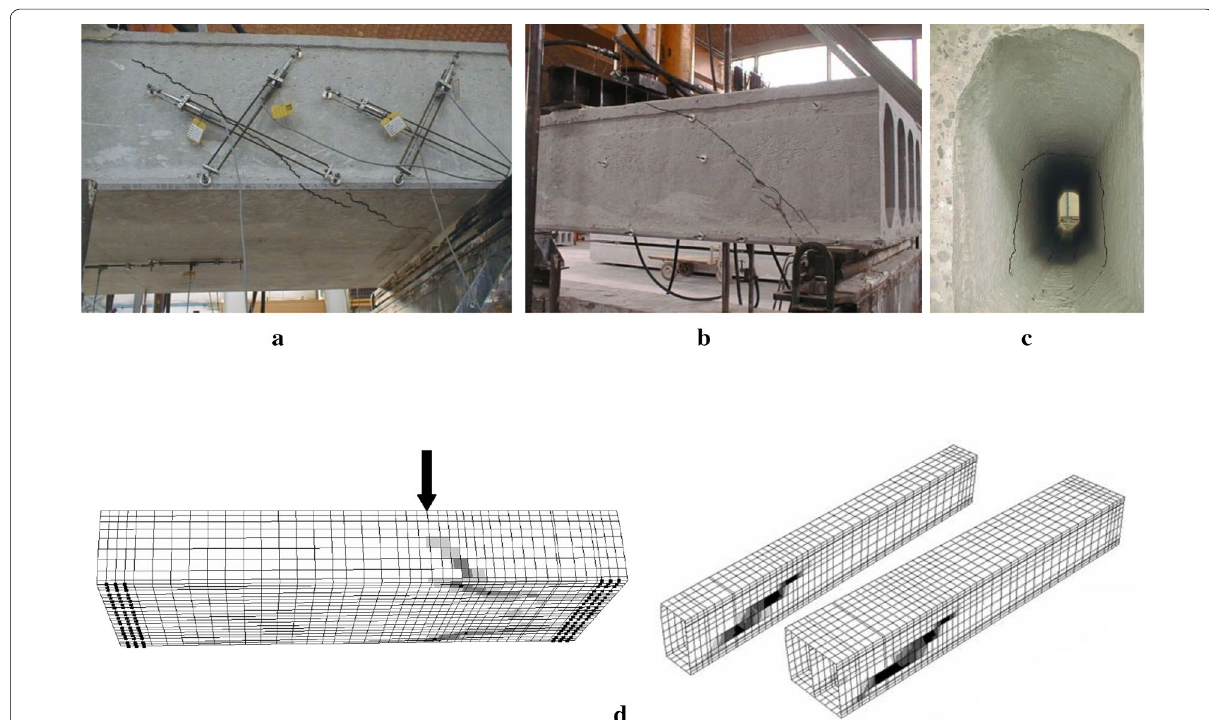
Fig. 18 Shear tests: comparison in terms of crack pattern at failure. Experimental crack pattern for a specimen H50-s1, and b , c specimen H50-s2; d crack distribution as obtained from the numerical model.